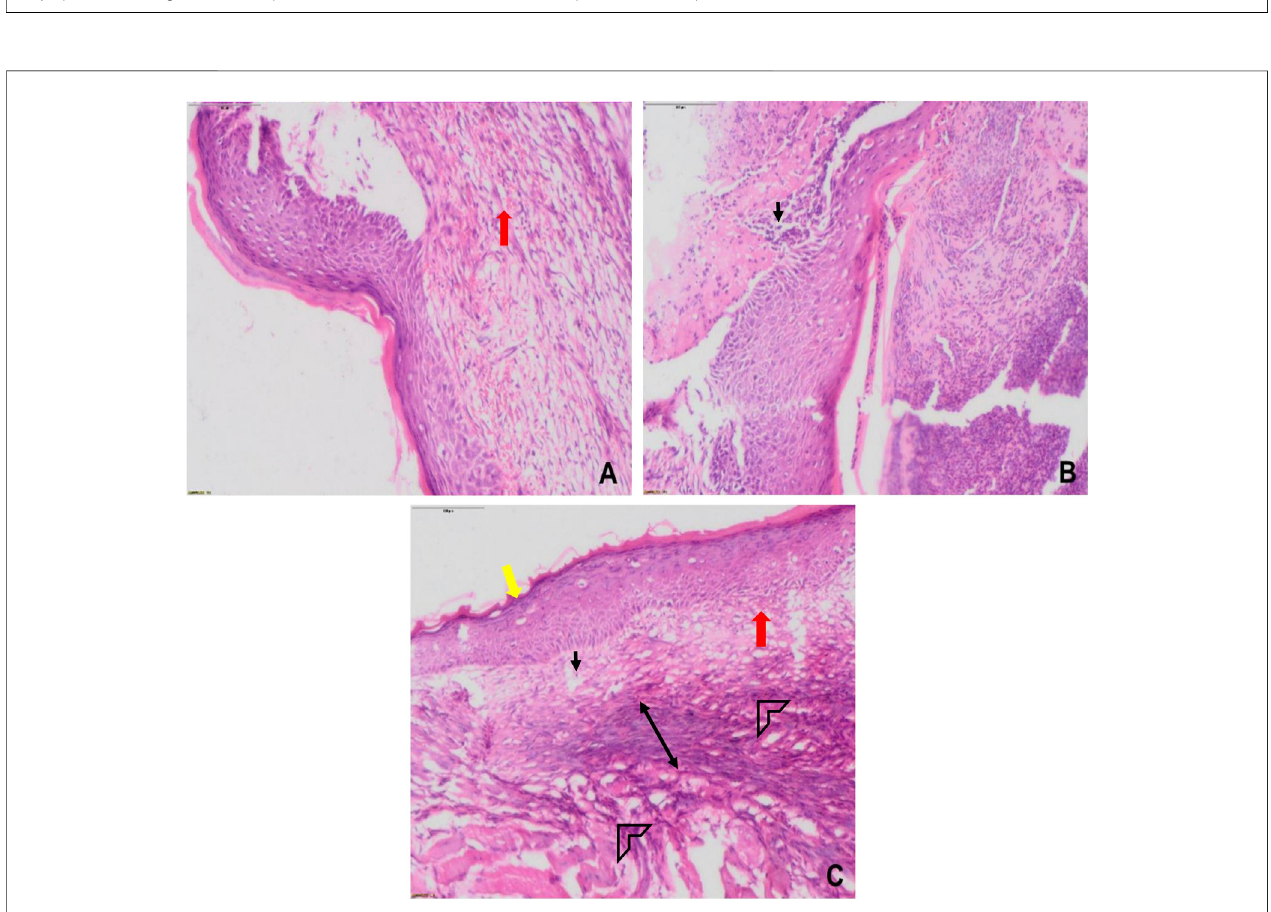
FIGURE 12 | Histological images of skin tissue from infected wounds on day 7: (A) vehicle (CMC), (B) Positive (betadine), (C) Lp2621 (scale bar (cid:1) 100 μ m). Fibroblasts (black), vascularization (red), re-epithelization (yellow), collagen deposition (arrow head), and granulation of tissue (double-sided arrow).